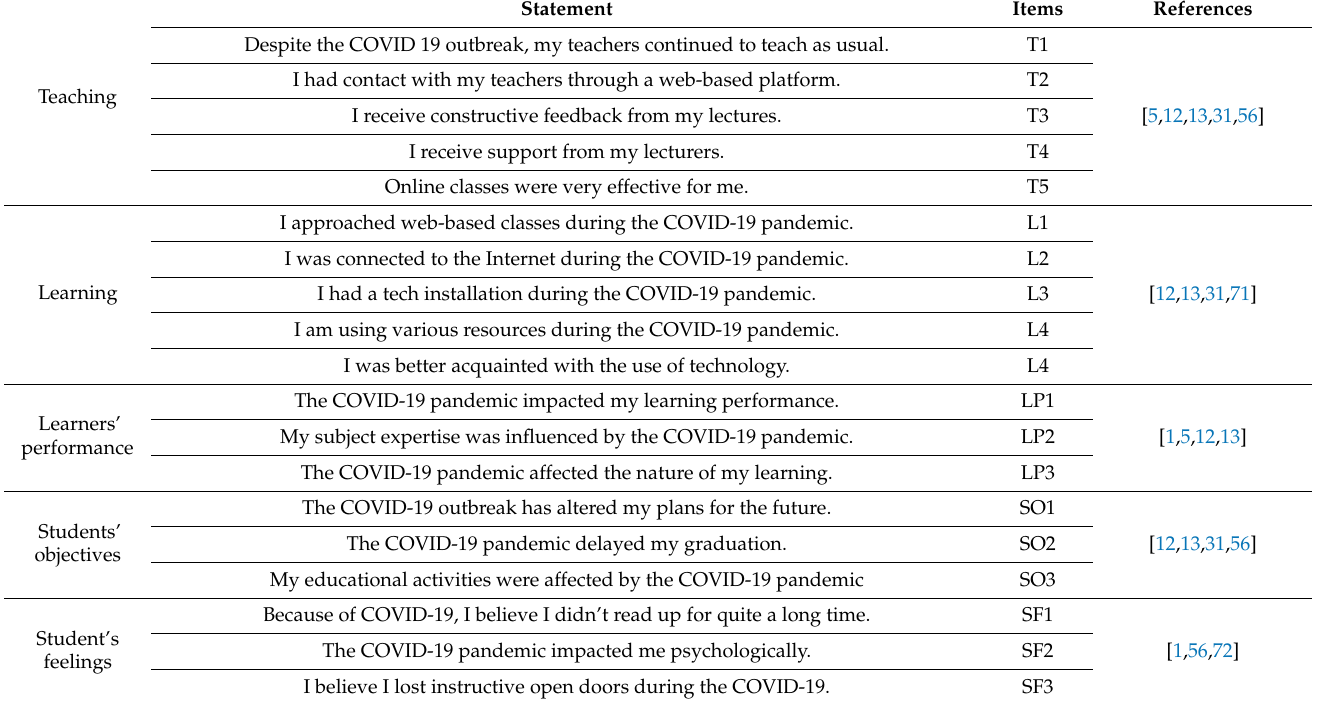
Table 2. Overview of the measurement items of the